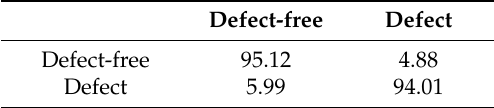
Figure 12. Visualization of the DCNN DND class evaluation results: ( a ) before and ( b ) after utilization of class probability update algorithm; class 0—defect not sensed by the transducer, class 1—defect indicated by the transducer; white dashed line depicts the circumference of the transducer.